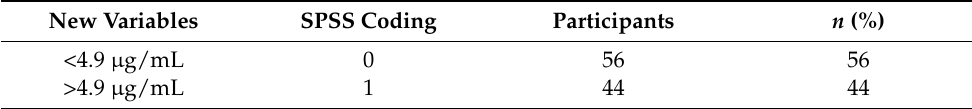
Table 9. Multivariate analysis of plasma vitamin E level.